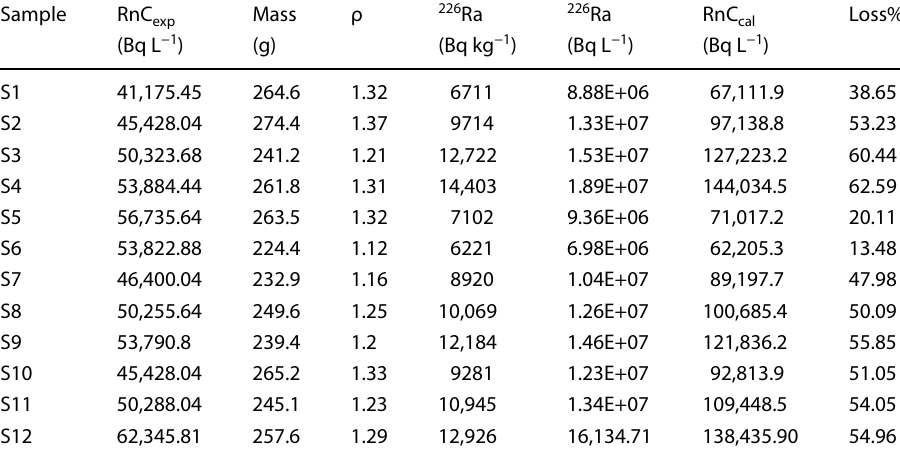
Table 3 Experimental and Calculated of Radon Concentration (Bq/L)